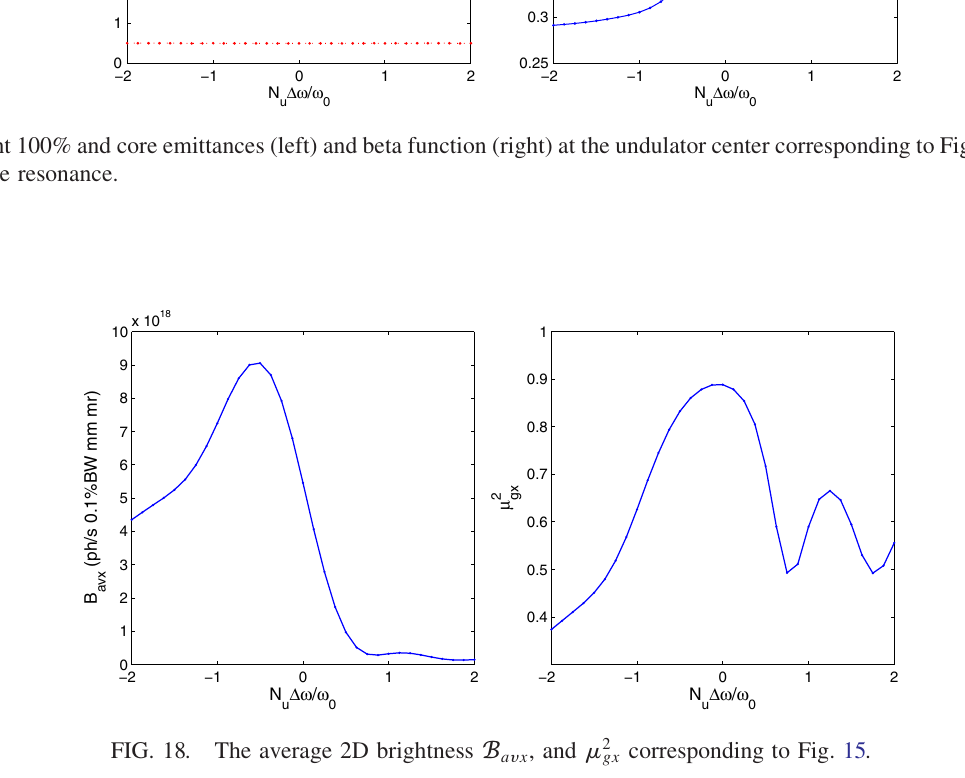
, and (cid:13) 2 corresponding to Fig. 15. gx avx